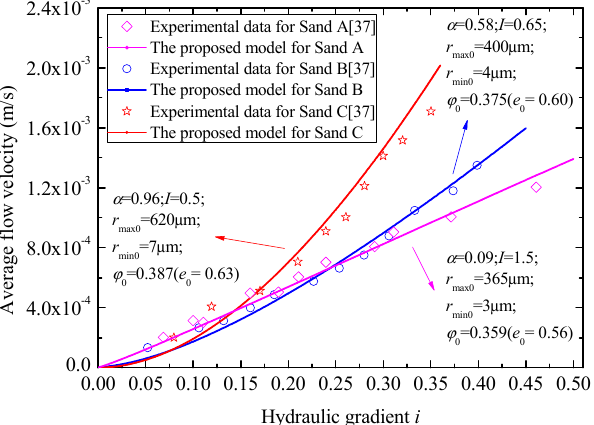
Figure 2. A comparison between the experimental data [37], and results of the proposed model.